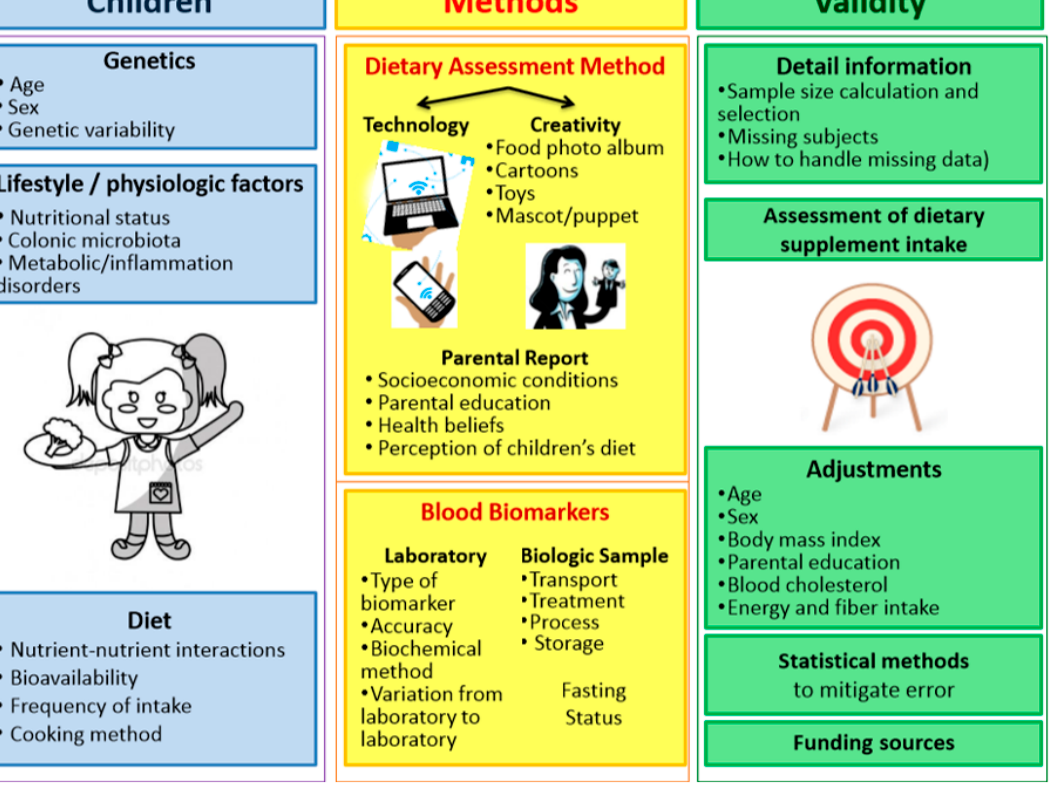
Figure 3. Main factors regarding the validity of dietary assessment methods in children.